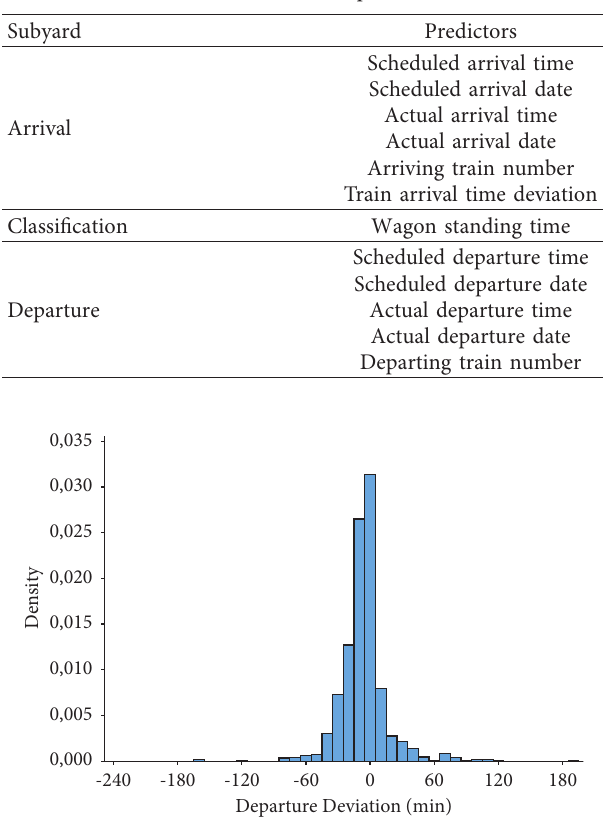
Figure 2: Histogram of departure deviations.